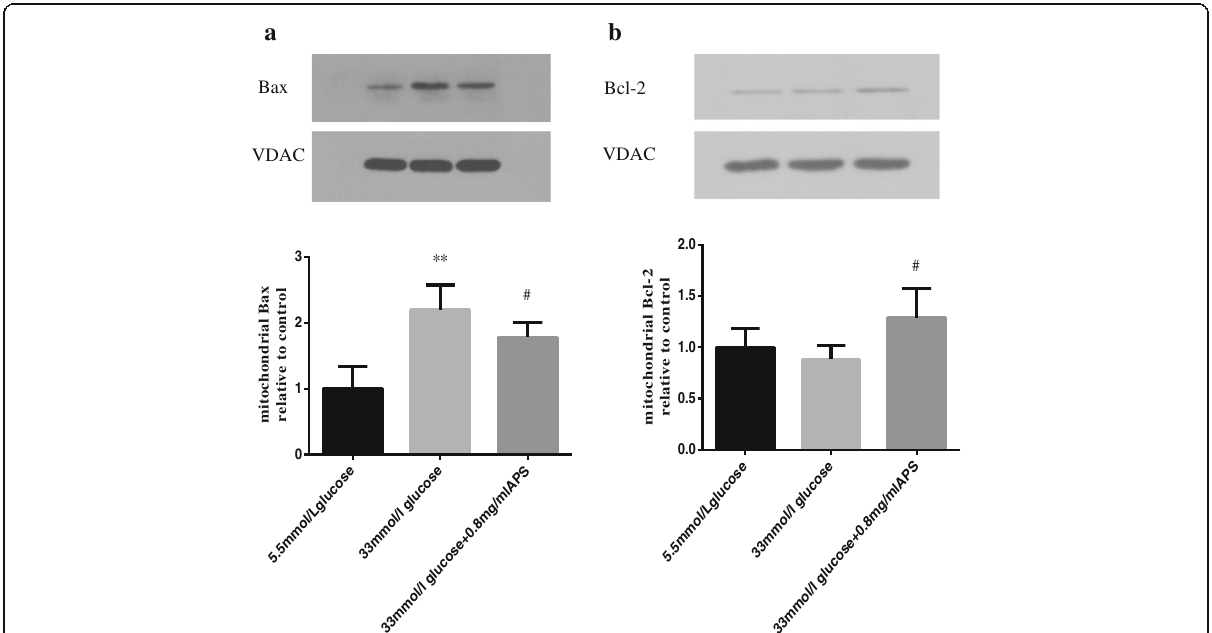
Fig. 9 APS modulated apoptosis-related proteins of the Bcl-2 family. H9C2 cells were pre-incubated with/without APS for 24 h and then treated with 33 mmol/L glucose for 24 h. The expression of VDAC was measured as an internal control for the mitochondrial proteins. a . Semi-quantitative expressions of mitochondrial Bax in different groups. b . Semi-quantitative expressions of mitochondrial Bcl-2 in different groups. Data were expressed as Mean ± SD. ** P < 0.01 versus 5.5 mmol/L glucose group; # P < 0.05 versus 33 mmol/L glucose